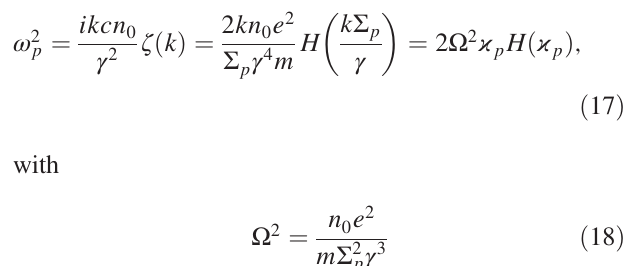
ffiffiffiffiffiffiffiffiffiffiffiffiffiffiffiffiffiffiffiffiffi p 2 ϰ H ð ϰ p